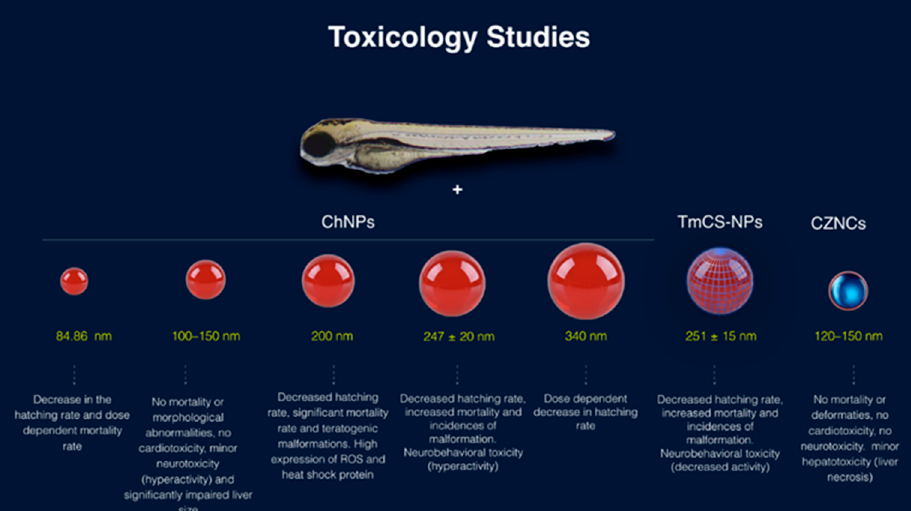
Figure 4. Summary figure representing the toxicity of different sizes of ChNPs, Tween modified Ch and Ch zinc oxide nanoparticles on zebrafish embryo. 4 studies investigated the toxicity of different sizes of ChNPs (100–340 nm). The smallest ChNPs tested for its toxicity sized 84.86 nm, in which it showed dose-dependent increase in mortality rate (LC50 280 mg / L), decrease in the hatching rate. 200 mg / L of ChNPs size ranging from 100 to 150 nm showed minor neurotoxicity (hyperactivity) and liver